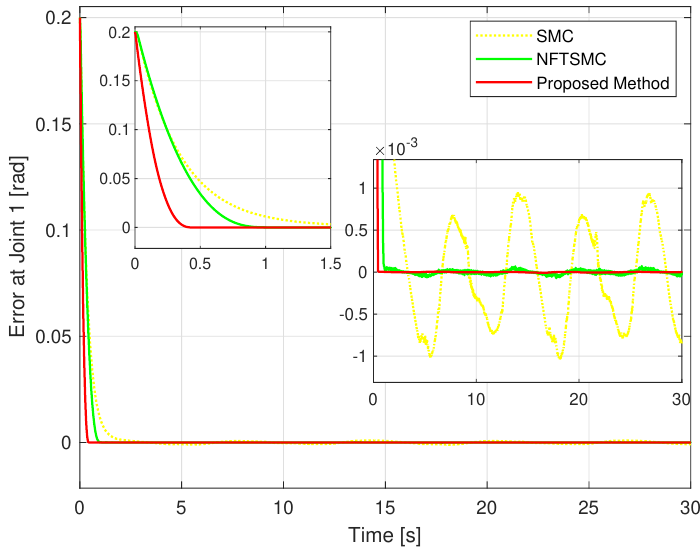
Figure 7. The TCE comparison between the position of the first joint and the desired path. In convergence terms, the suggested HTCA also has the best performance, its TCEs quickly reach equilibrium in the shortest time, while the TCEs of the NFTSMC converge to equilibrium faster than those of the conventional